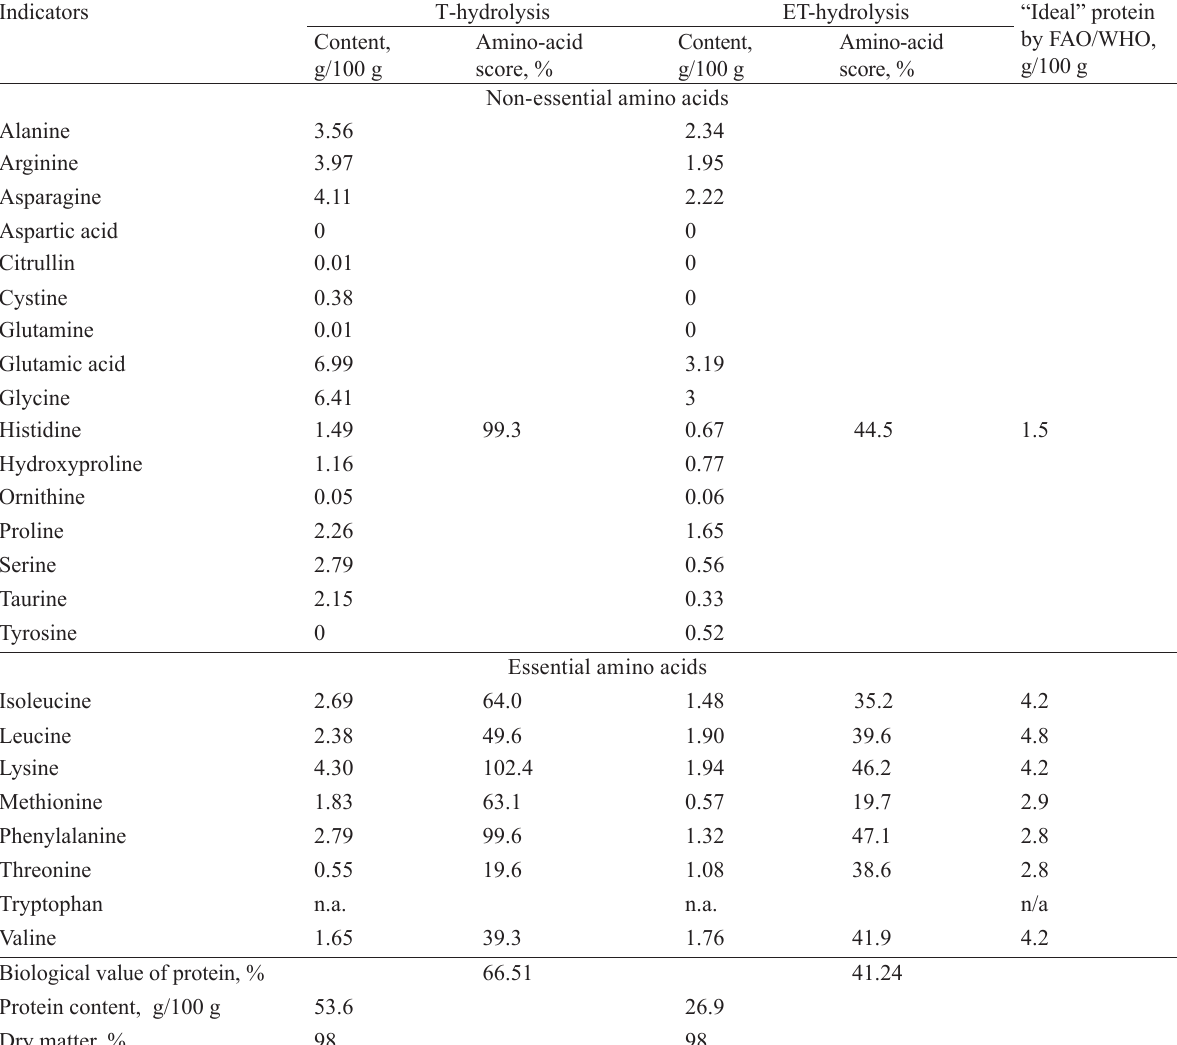
Table 8 Amino-acid profiles of sediments after hydrolysis of sockeye heads after thermal and enzymatic-thermal hydrolysis